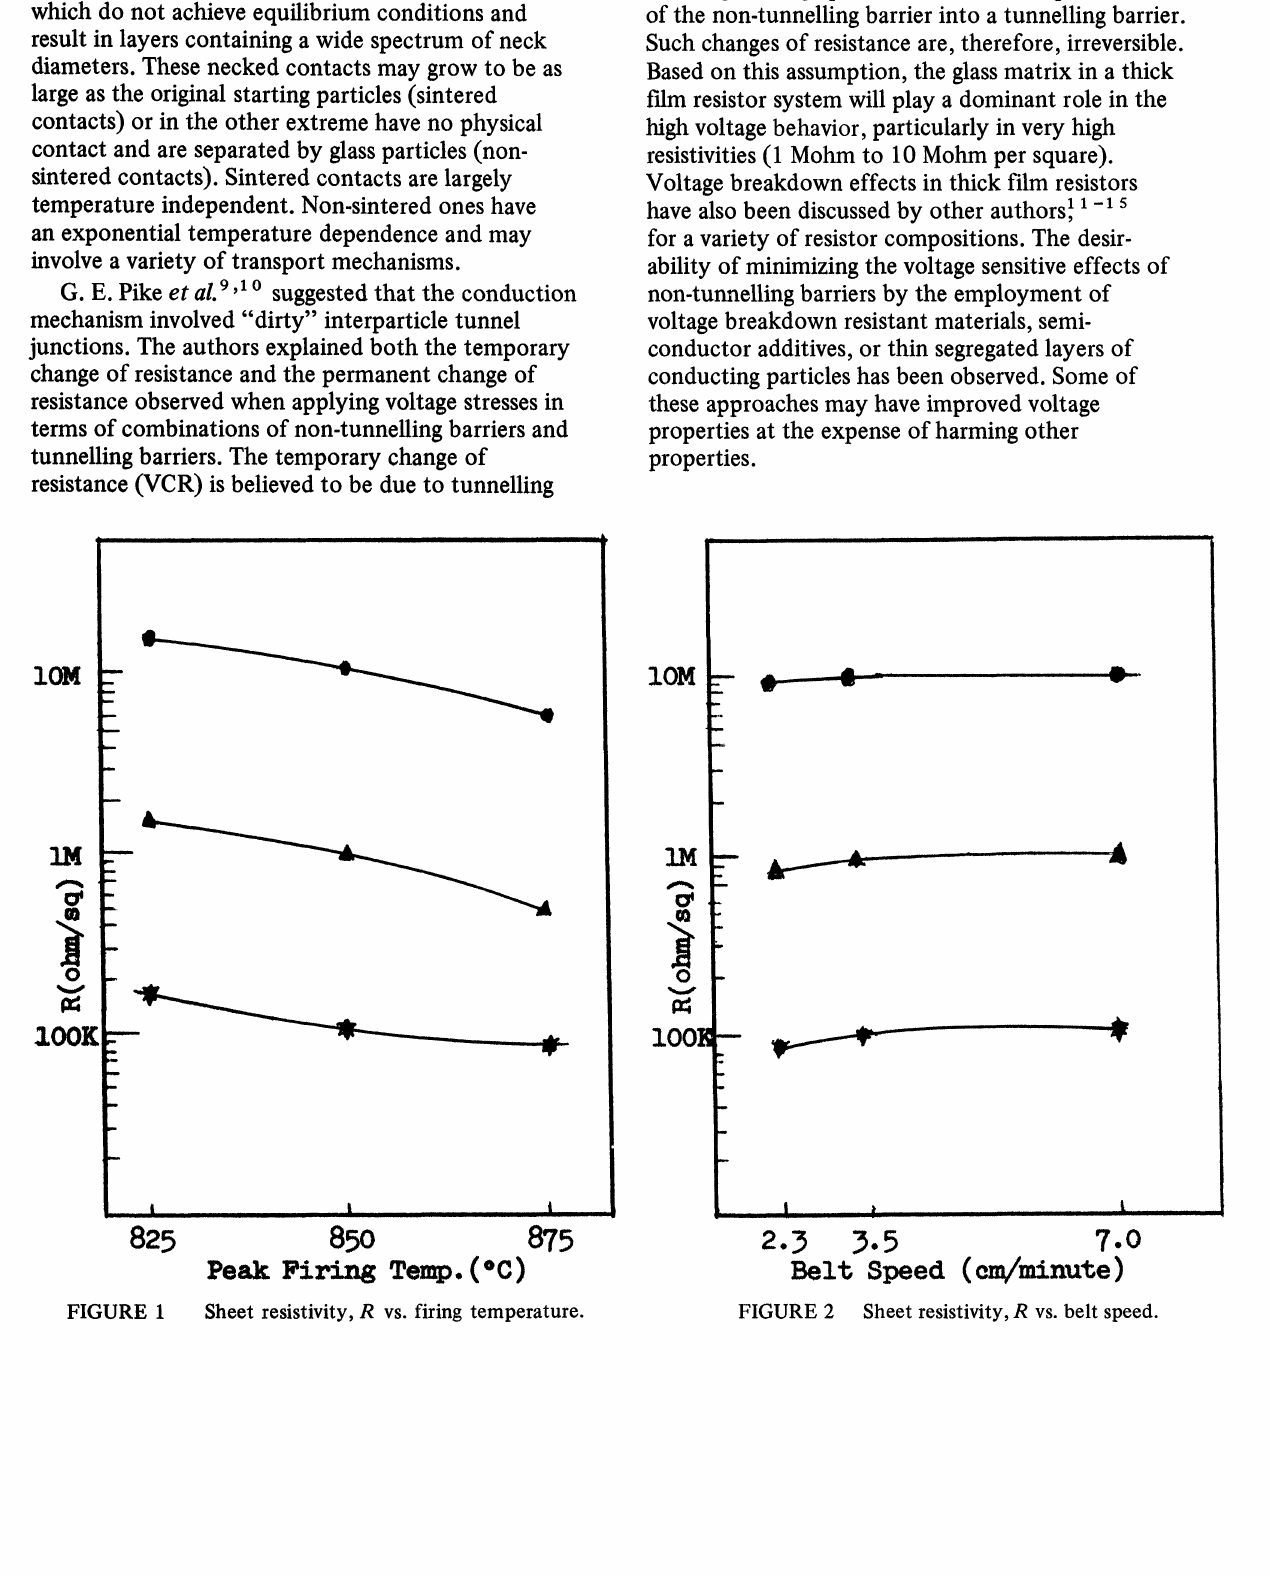
Sheet resistivity, R vs. firing temperature. FIGURE 2 Sheet resistivity, R vs. belt